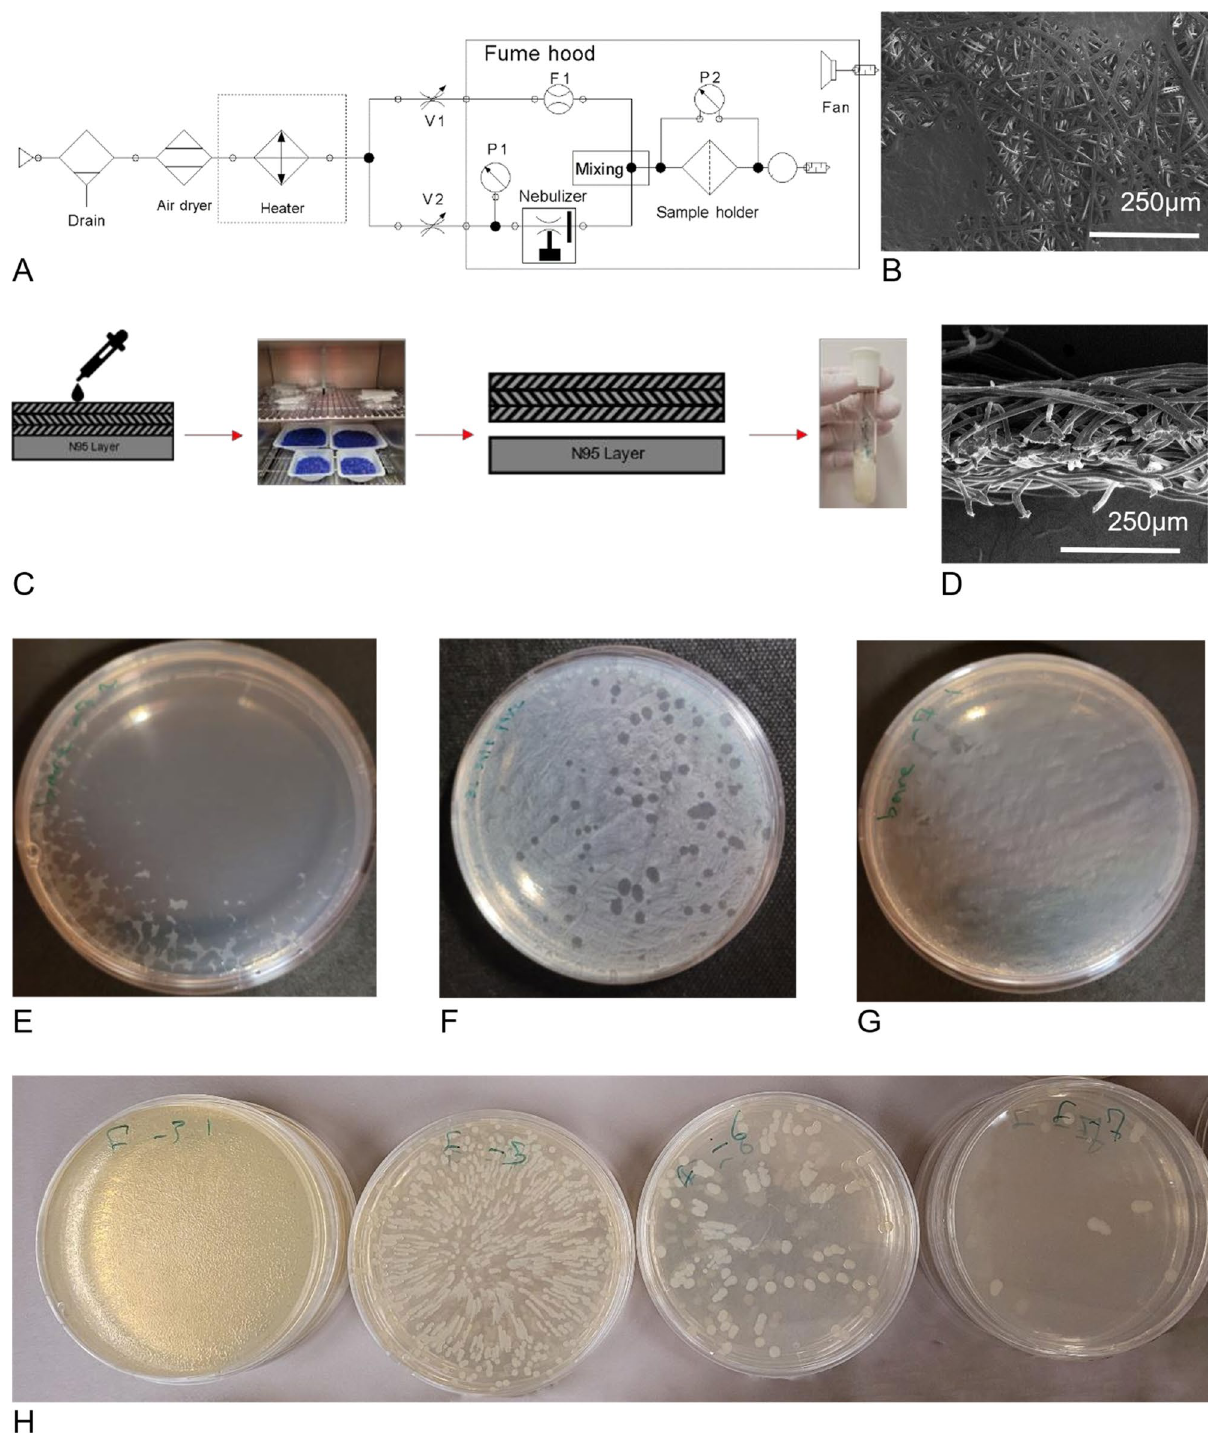
Figure 7. ( A ) A cross-sectional view of an uncoated filter; ( B ) The top view of an uncoated filter; ( C ) The testbed schematic used for coating and pressure drop experiments; ( D ) The procedure used to perform filter- involved experiments; ( E ) A fully infected Petri dish; ( F ) Discrete plaques are formed on surface of the Petri dish; ( G ) A non-infected Petri dish; ( H ) The assay of the bacterial stability